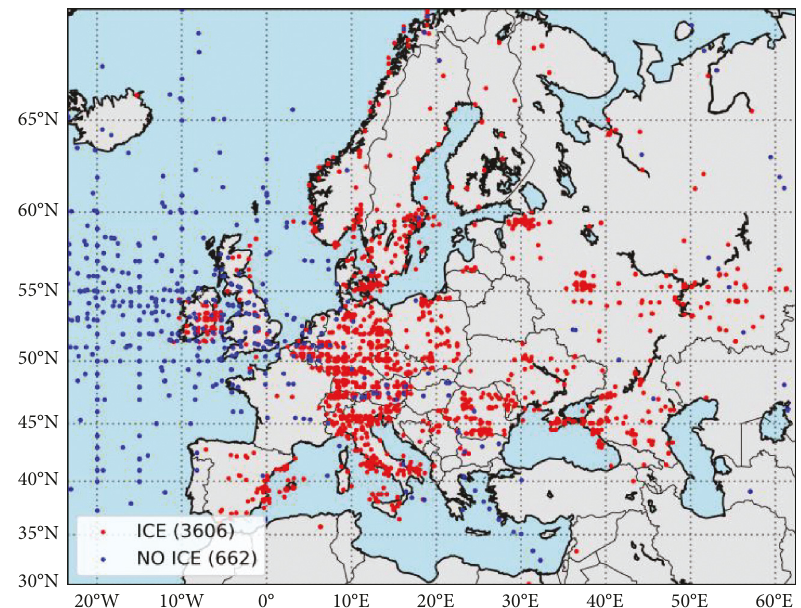
Figure 1: Geographical distribution of the PIREPs used in this study. The area shown represents the geographical coverage of HarmonICE.